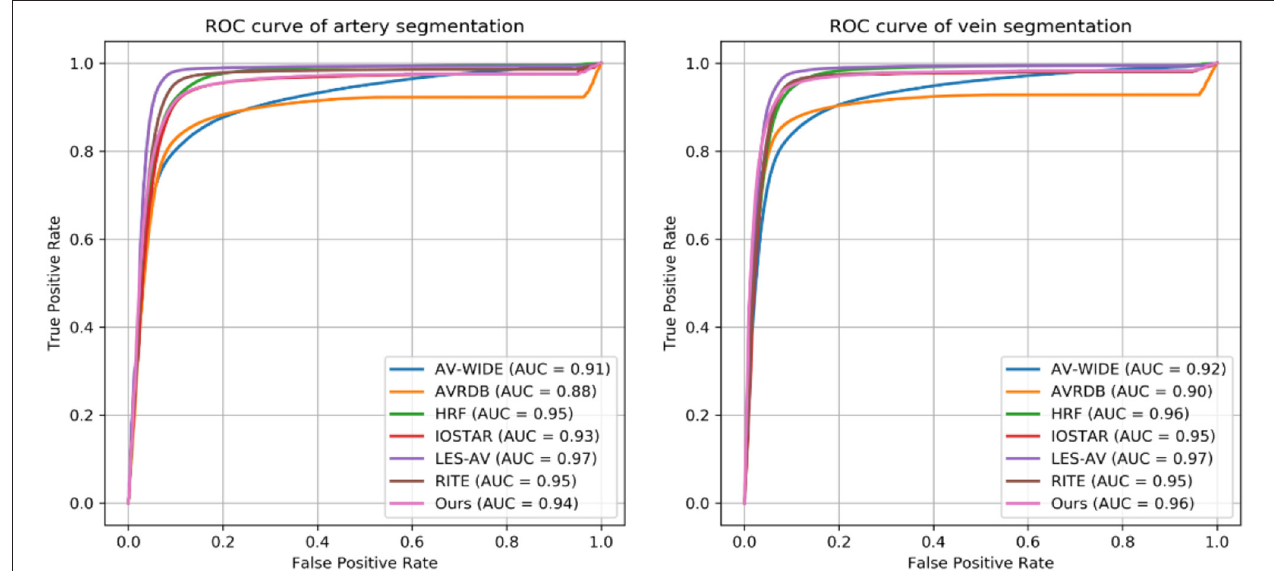
TABLE 3 | Segmentation performance of Retina-based Microvascular Health Assessment System (RMHAS) on the test set in different datasets. Accuracy Sensitivity Specificity F1 score Artery